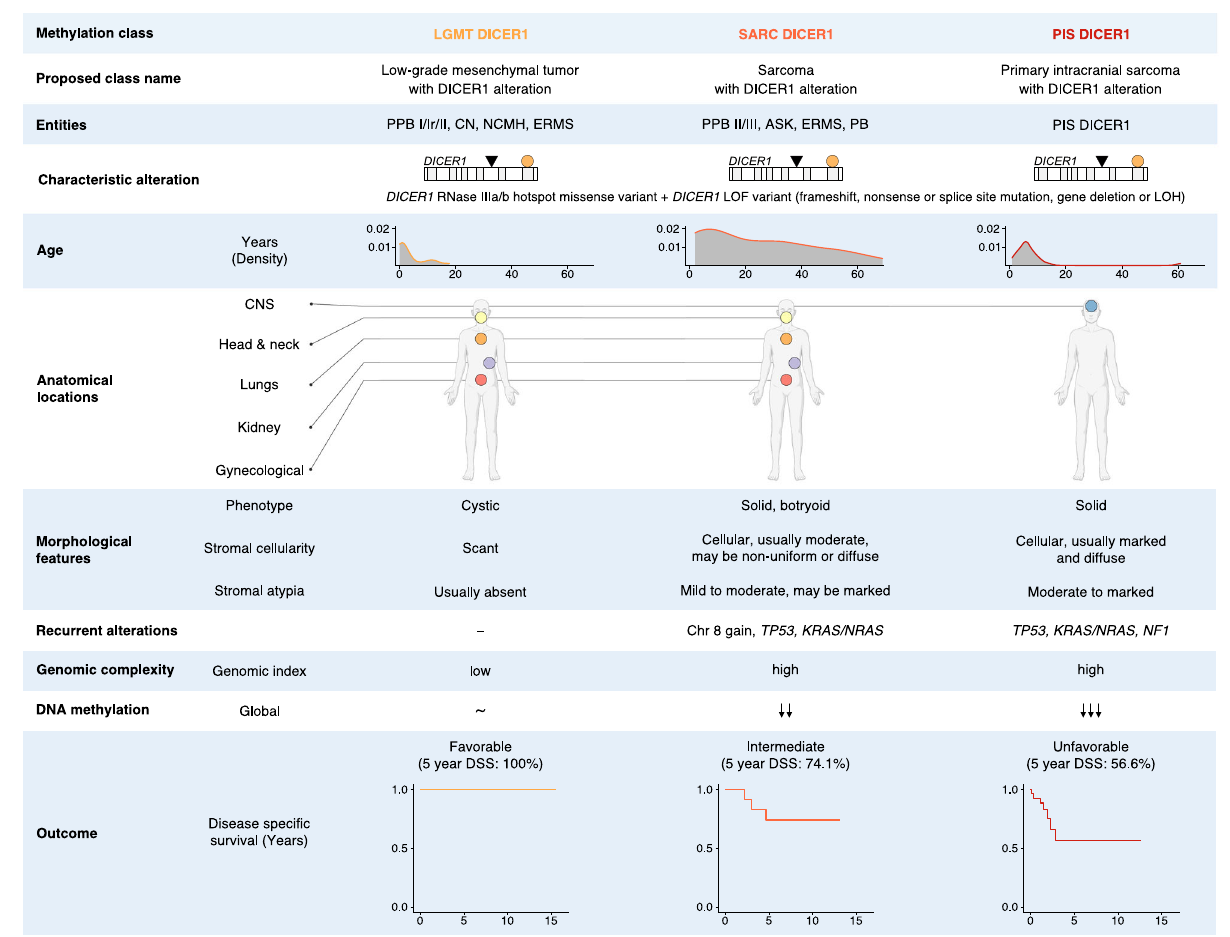
Fig.6|SummaryofclinicopathologicalandmolecularcharacteristicsofclassesofmesenchymalneoplasmswithDICER1alteration. LOFLossoffunction,LOHLoss of heterozygosity.